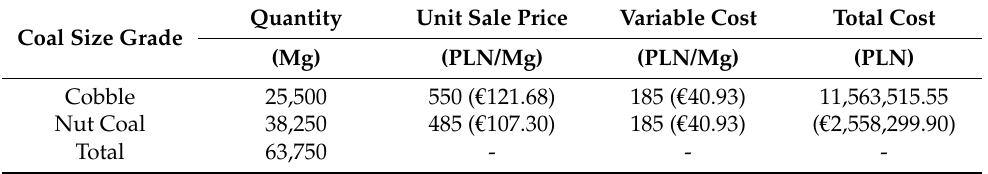
Table 1. Assumed value of production and economic indicators of mine “X” in a monthly take. Quantity Unit Sale Price Variable Cost Total Cost Coal Size Grade (Mg) (PLN/Mg) (PLN/Mg) (PLN) Cobble 25,500 550 ( € 121.68) 185 ( € 40.93) 11,563,515.55 Nut Coal 38,250 485 ( € 107.30) 185 ( € 40.93) ( € 2,558,299.90) Total 63,750 - -